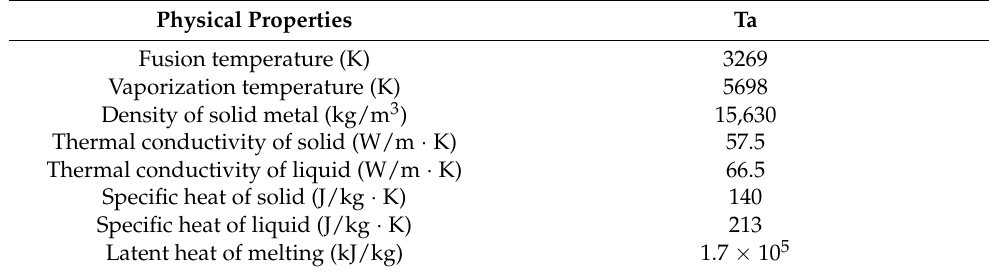
Table 1. Standard physical properties of pure tantalum.